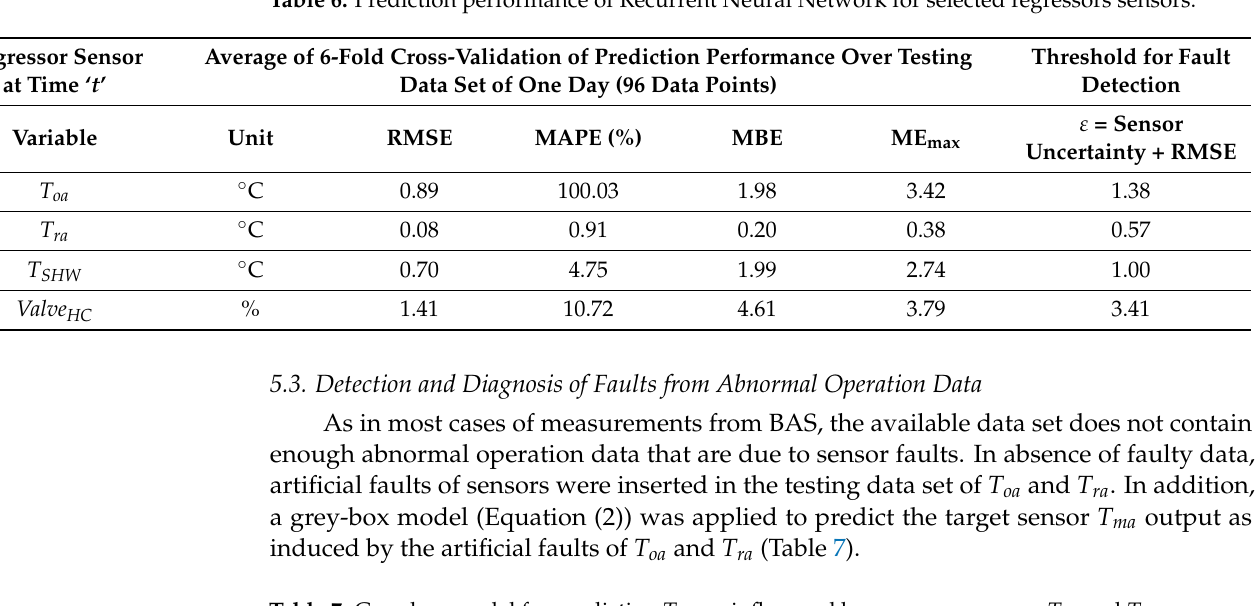
Table 6 . Prediction performance of Recurrent Neural Network for selected regressors sensors .